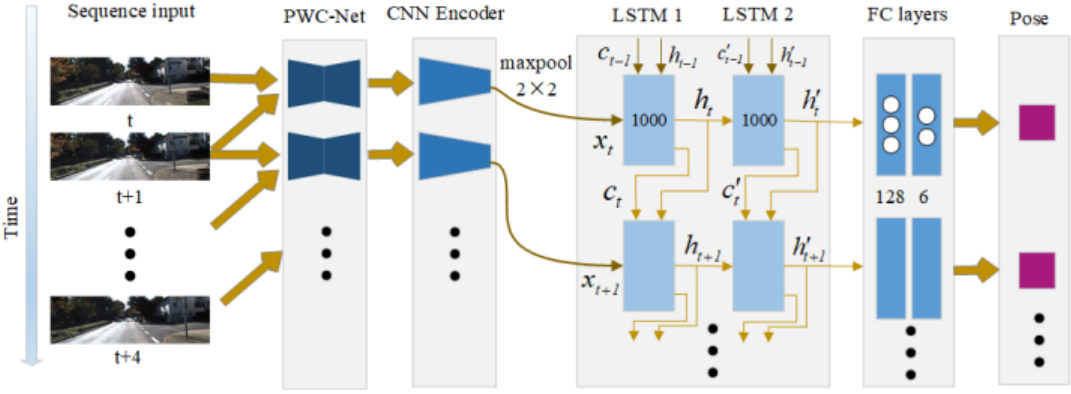
Figure 5. The architecture of LS-RCNN-VO model in its end-to-end